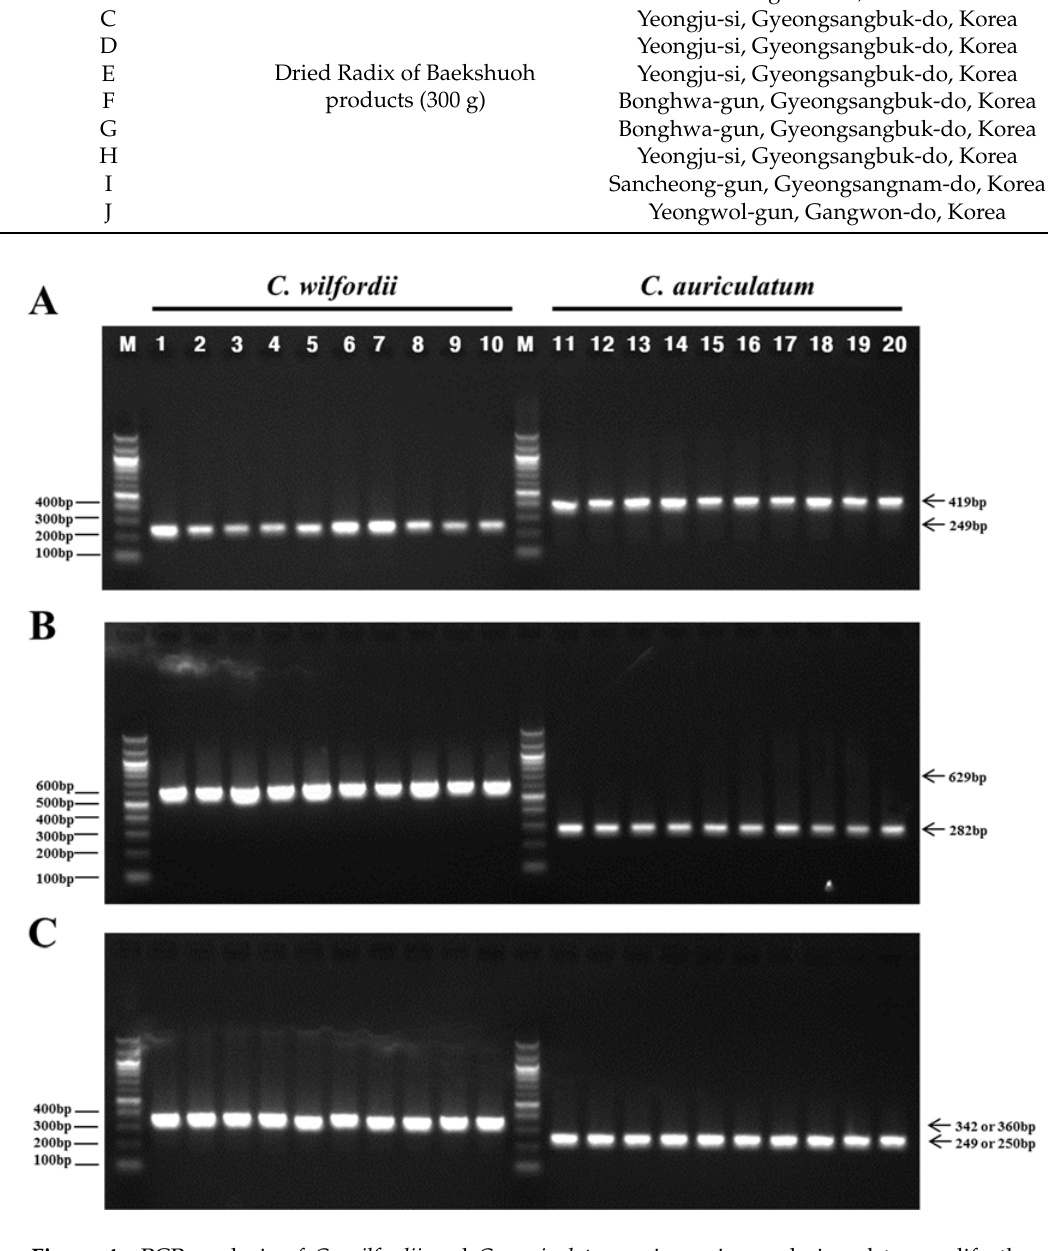
Figure 4. PCR analysis of C. wilfordii and C. auriculatum using primers designed to amplify the trnQ ‐ psbK ( A ), rps2 ‐ rpoC2 ( B ), and psaJ ‐ rpl33 ( C ) IGS regions. Lanes 1 to 10 are amplicons from C. wilfordii trnQ-psbK ( A ), rps2-rpoC2 ( B ), and psaJ-rpl33 ( C ) IGS regions. Lanes 1 to 10 are amplicons from C. wilfordii DNA; Lanes 11 to 20 are amplicons from C. auriculatum DNA; M, 100 bp DNA